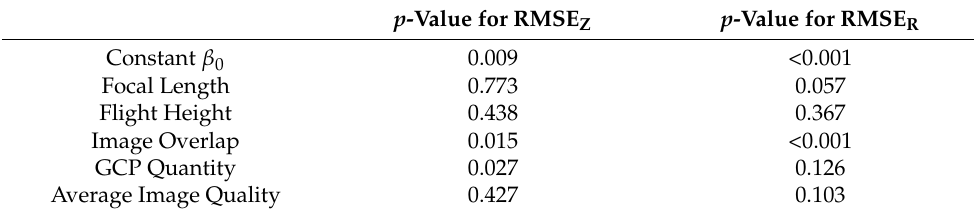
Table 6. Level of Significance of Influence Factors. p -Value for RMSE Z p -Value for RMSE R